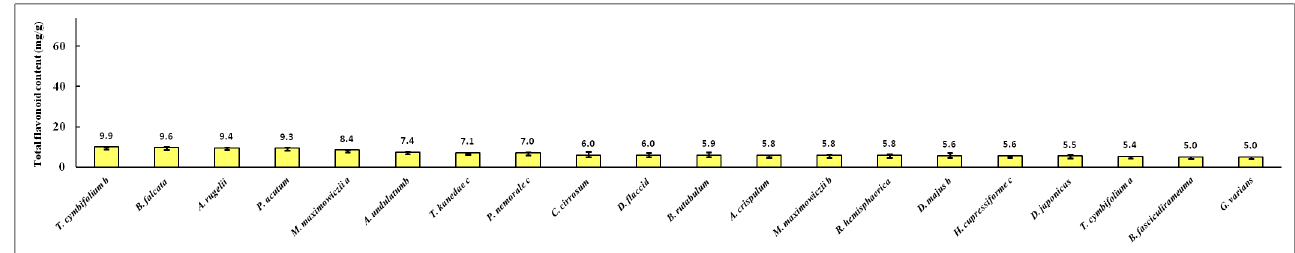
Fig 2. Bryophyte Samples with total flavonoid concentration between 5.0 and 10.0